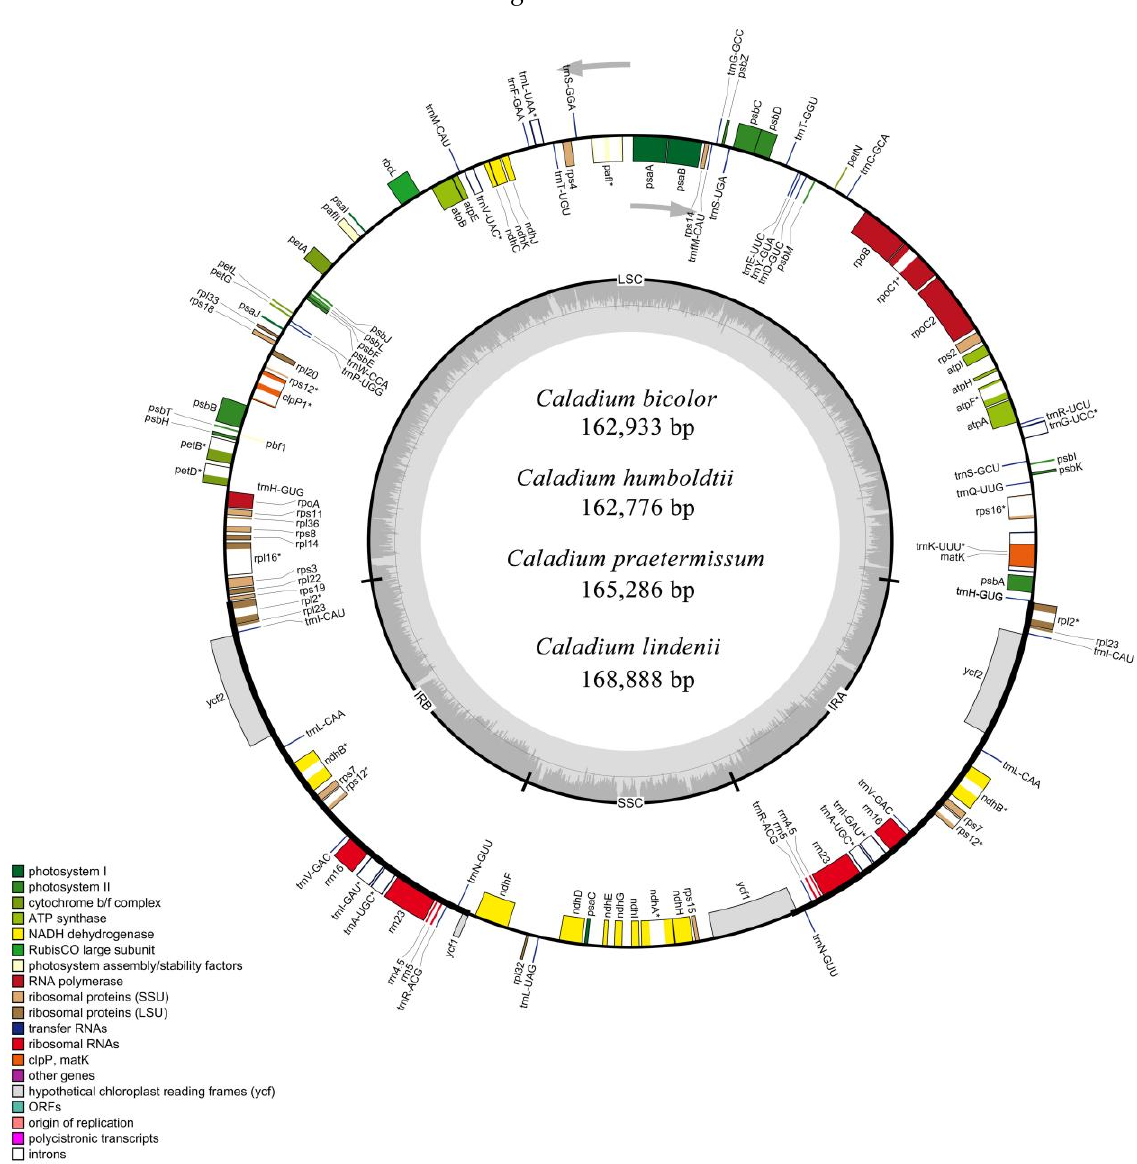
Figure 1. Circular gene map of the complete chloroplast genomes of four Caladium species.